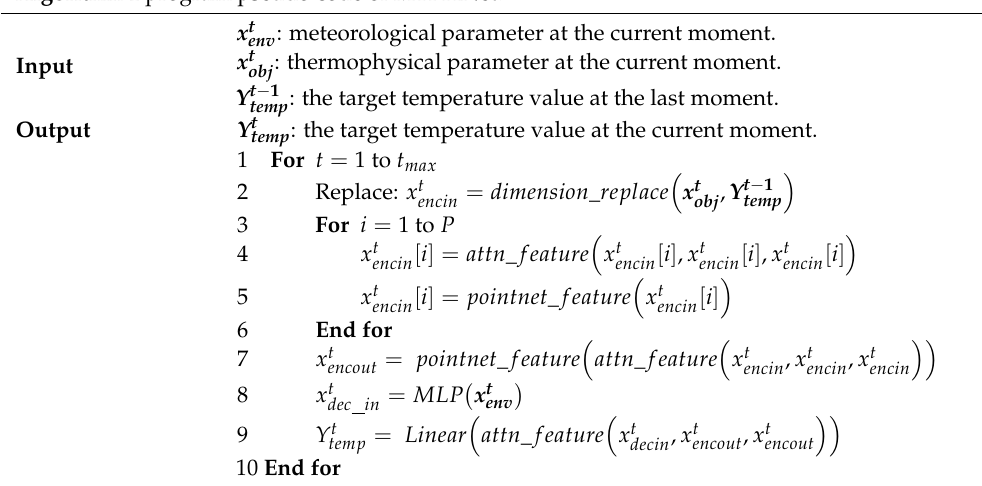
Algorithm 1 program pseudo code of